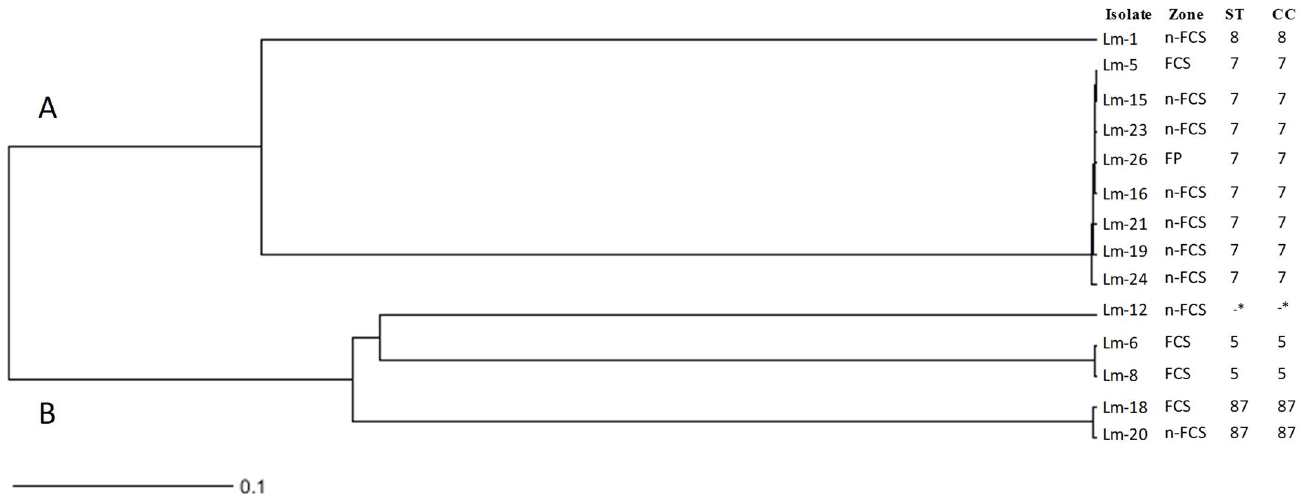
Figure 2. Dendrogram showing the relationships among the 14 L. monocytogenes isolates obtained from the final product (FP), FCS and n-FCS of the frozen vegetable plant. The dendrogram was generated using the unweighted pair group method with averages (UPGMA). Information on the isolate identification, sampling zone, sequence type (ST) and the unique clonal complex (CC) of each L. monocytogenes strain is shown. -* Unknown.